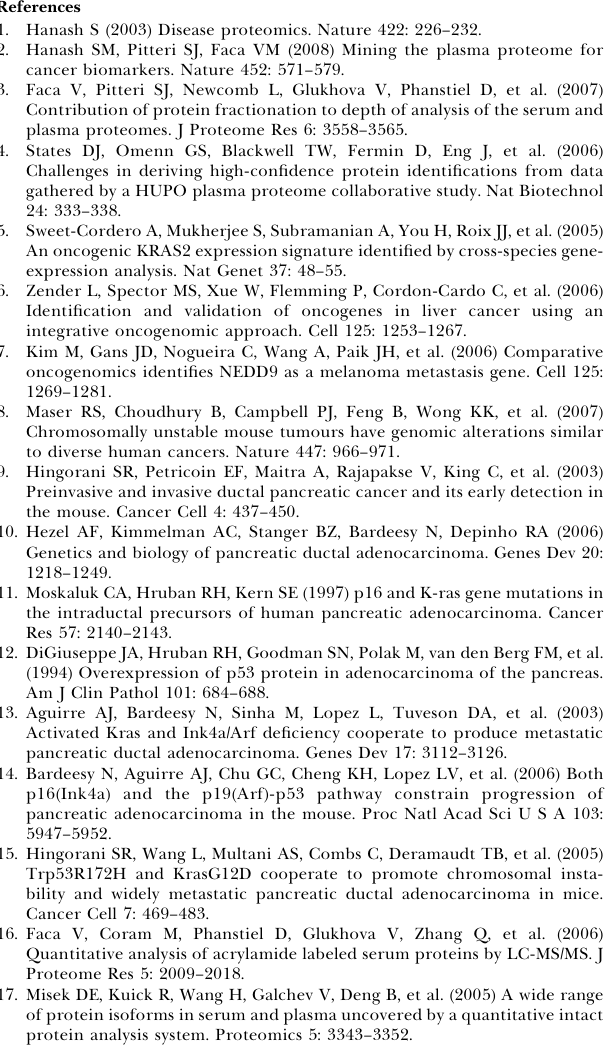
Figure S2. Concordance in Protein Identification between PanIN and PDAC Experiments (A) High abundant proteins were detected consistently in both PanIN and PDAC experiments, while low abundant proteins were more susceptible to sampling limitations in data acquisition for LC–MS/MS. (B) Protein identification concordance between duplicate runs of fractions. Reversed-phase fractions from anion exchange fraction 6 of both PanIN and PDAC were run in duplicate, and the same behavior was observed. Protein concentration was estimated on the basis of spectral counts (Figure 3). The majority of medium to high abundance proteins ( . 1 l g/ml or . 100 ms events) were detected in both PanIN and PDAC experiments, while most differences in protein identifications between the two experiments represented lower abundance proteins. Figure S3. Protein Tissue Distribution Versus Relative Protein Abundance